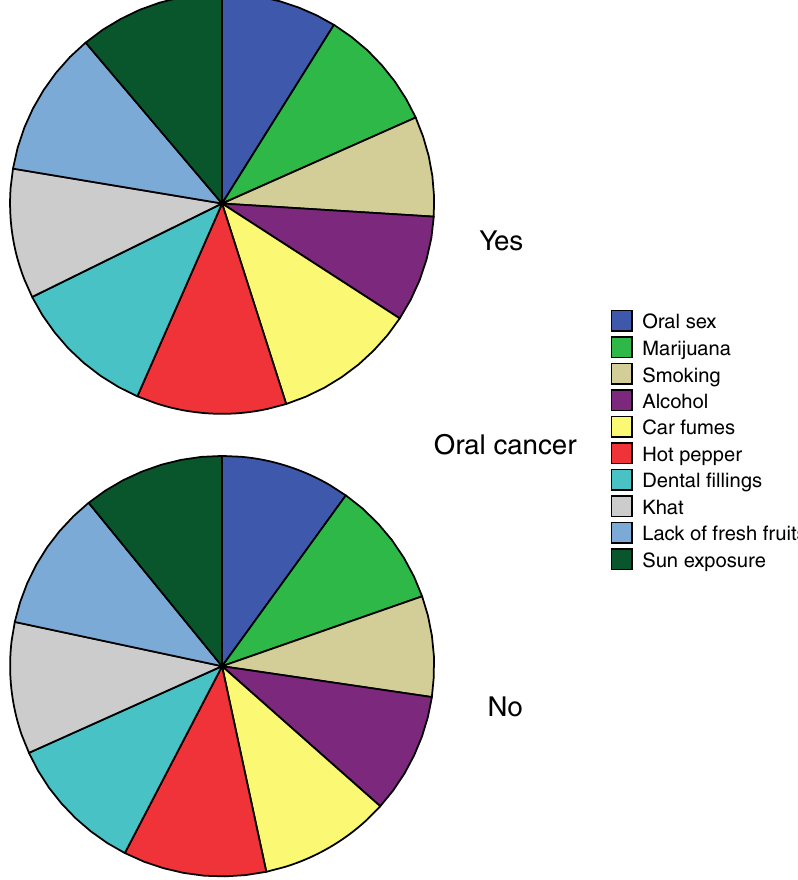
Figure 1. Shows responses to factors associated with oral cancer against oral cancer